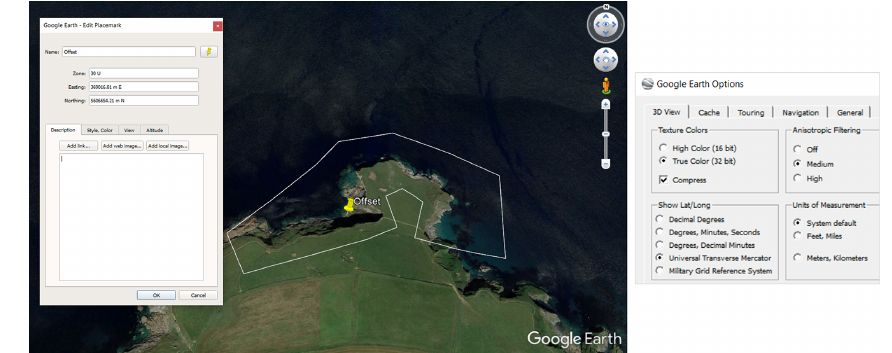
Figure A1. Use a GIS or earth viewer such as Google Earth (© Google Earth) to define coordinate offsets for model processing and export.